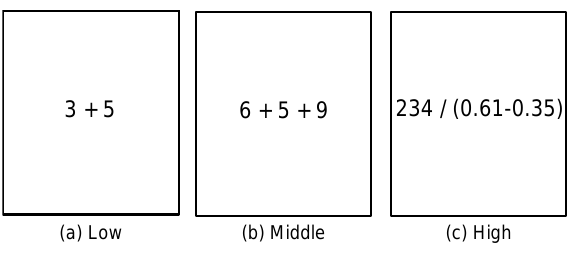
Fig. 4. Example of Arithmetic